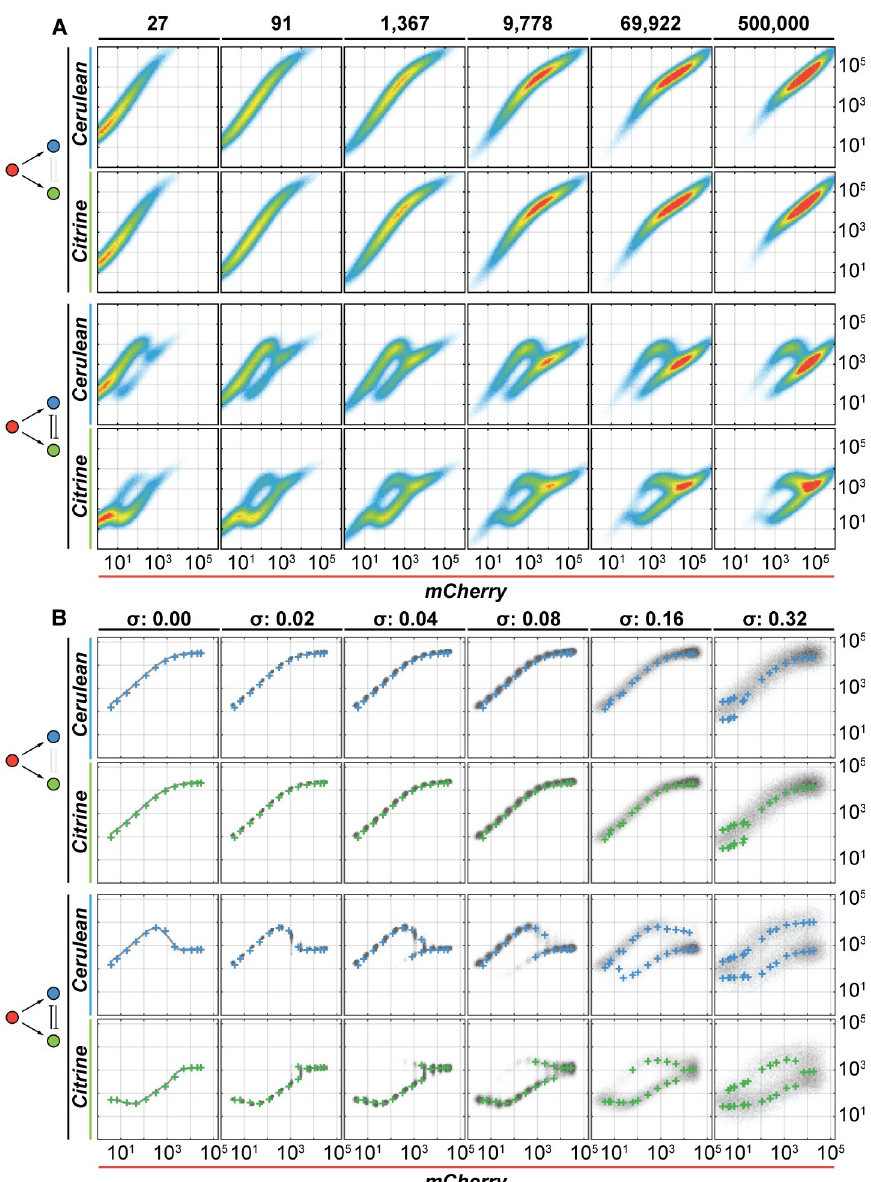
Fig 5. Results of PFAFF analysis on simulated FO and RIFFM flow cytometry data set. (A) Raw simulated transient transfection data for circuits FO and RIFFM at noise level σ = 0.16, modulated by different input levels of Doxycycline (columns). Each circuit (FO, RIFFM) is represented by two rows of charts depicting the input versus their respective output signals. (B) Simulated flow cytometry data set of the bin that lies at the transfection reference protein’s global mean (transfection reference: SBFP2) at different gene expression noise levels σ (columns) ranging from 0.00–0.32. The plots show the input/output curves extracted by PFAFF (colored crosses; top row: Cerulean, bottom row: Citrine) atop of the simulated stably integrated circuit at the indicated gene expression noise level σ (grey density plot). FO undergoes an activation in both output colors. The RIFFM circuit shows a bi-modal behavior already at low noise levels for both output